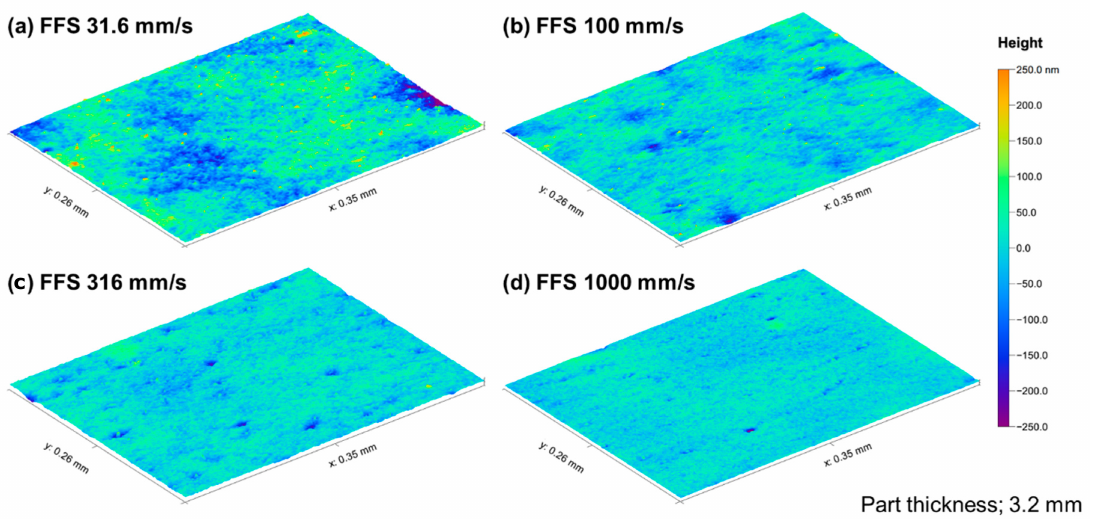
Figure 7. Surface topography molded by various flow-front speeds (FFS); ( a ) 31.6 mm / s, ( b ) 100 mm / s, ( c ) 316 mm / s, and ( d ) 1000 mm / s.